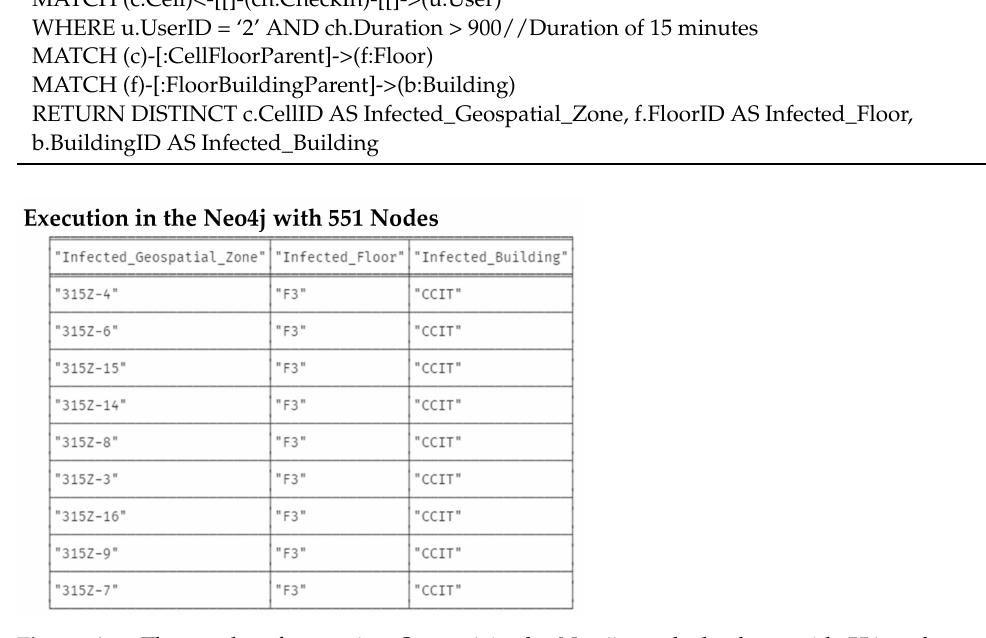
Figure A5. The results of executing Query 1 in the Neo4j graph database with 551 nodes and 1149 relationships: the first column of results shows contaminated indoor cells, while the second and third columns show the floor and building in the hierarchical graph data